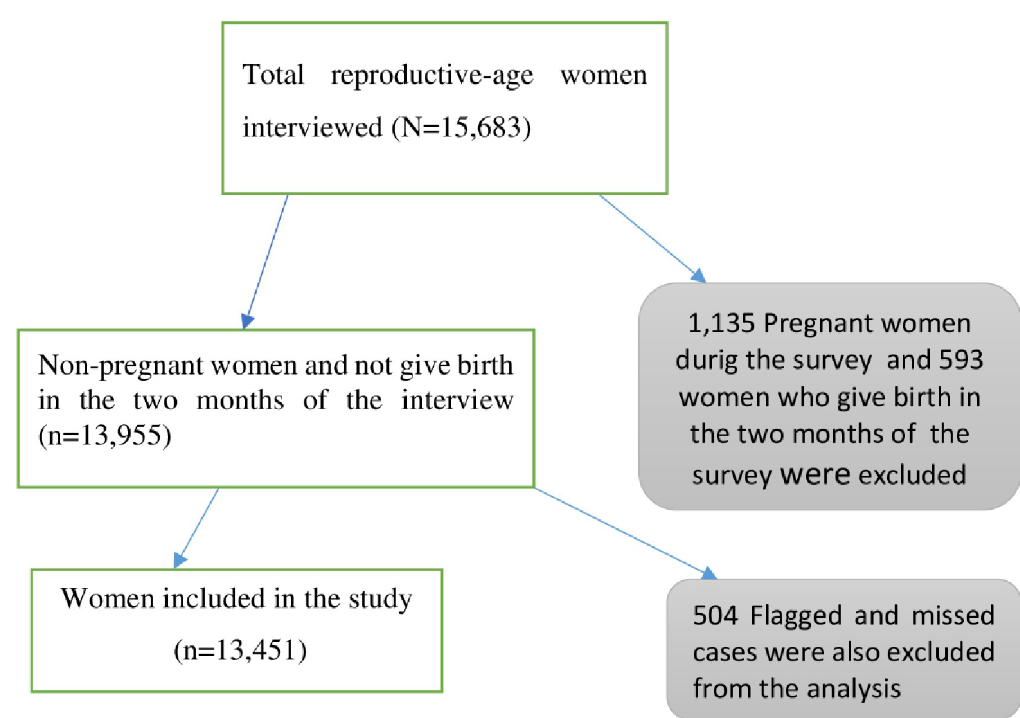
Fig 1. Schematic presentation showing a sampling of women with underweight in the 2016 EDH),